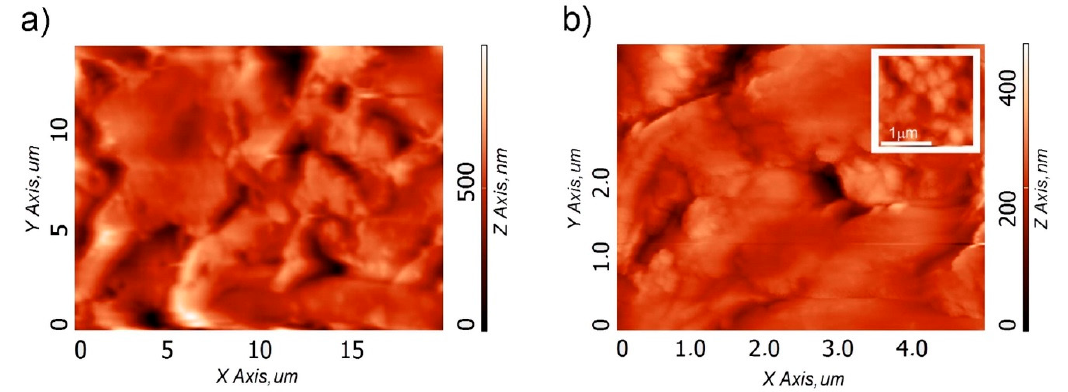
Figure 5. Atomic force microscopy (AFM) images of the sample C cryogel surface at: lower ( a ) and higher ( b ) magnifications. The inlet in ( b ) represents a magnification of the flat area.